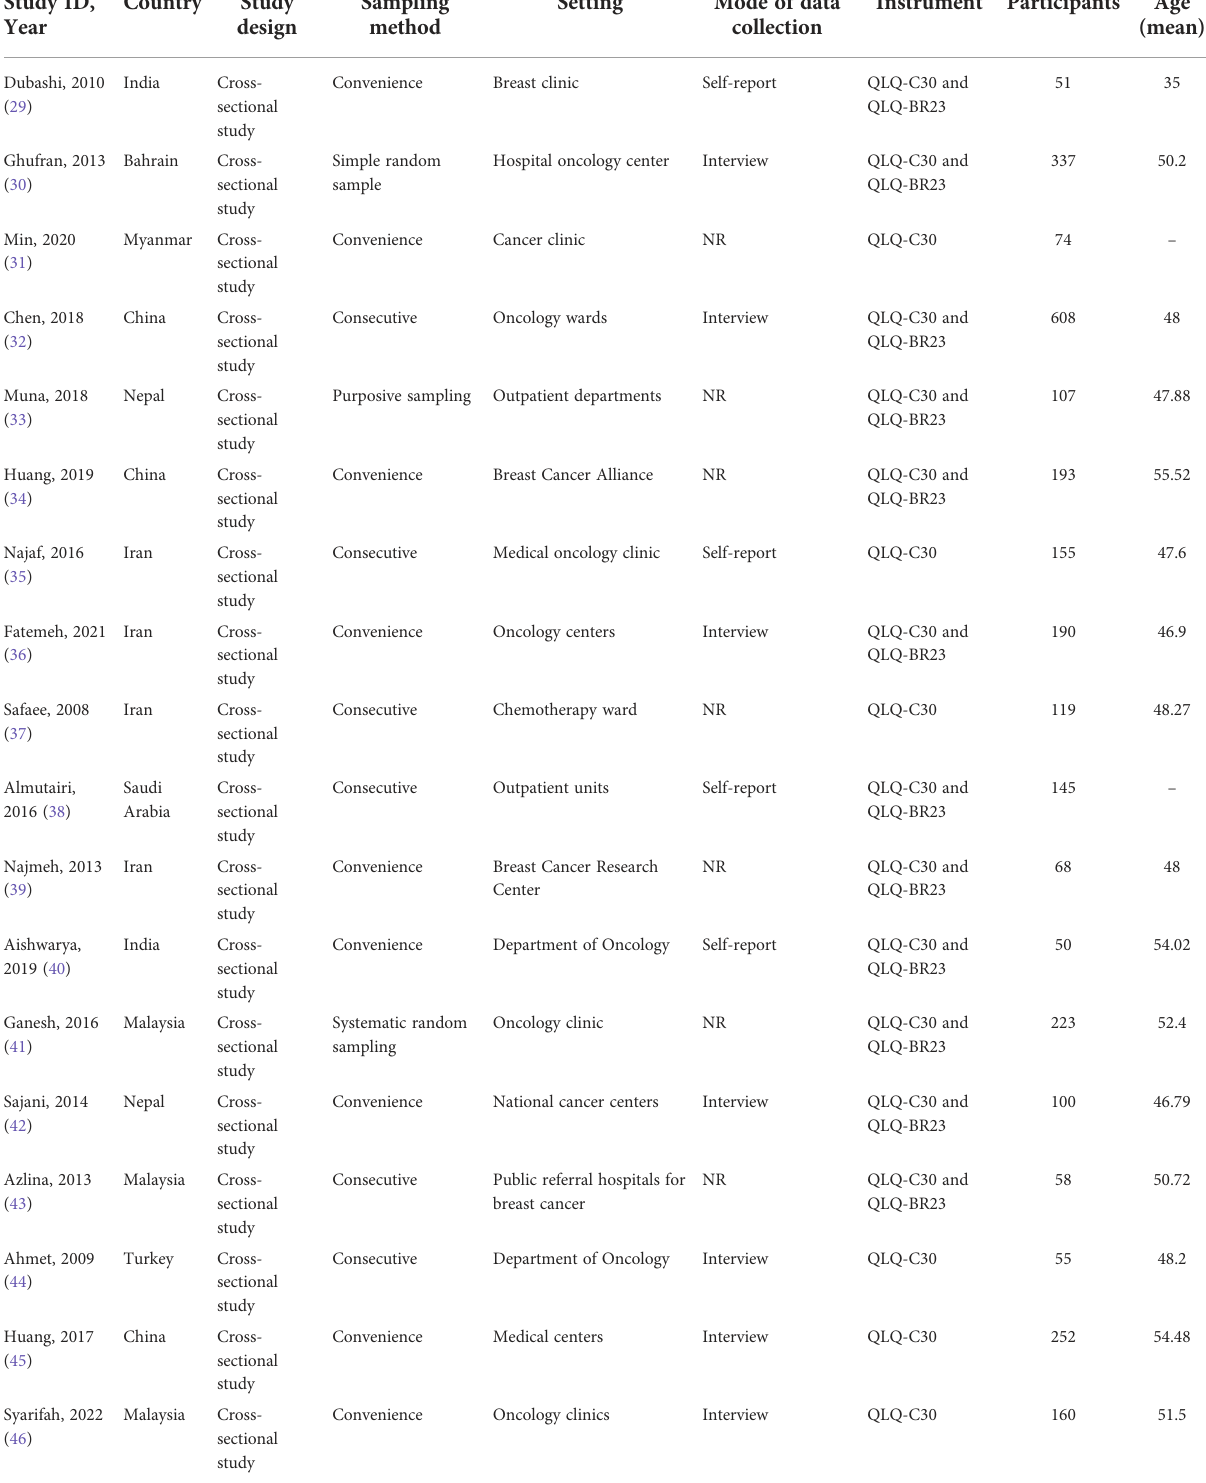
TABLE 1 Characteristics of enrolled